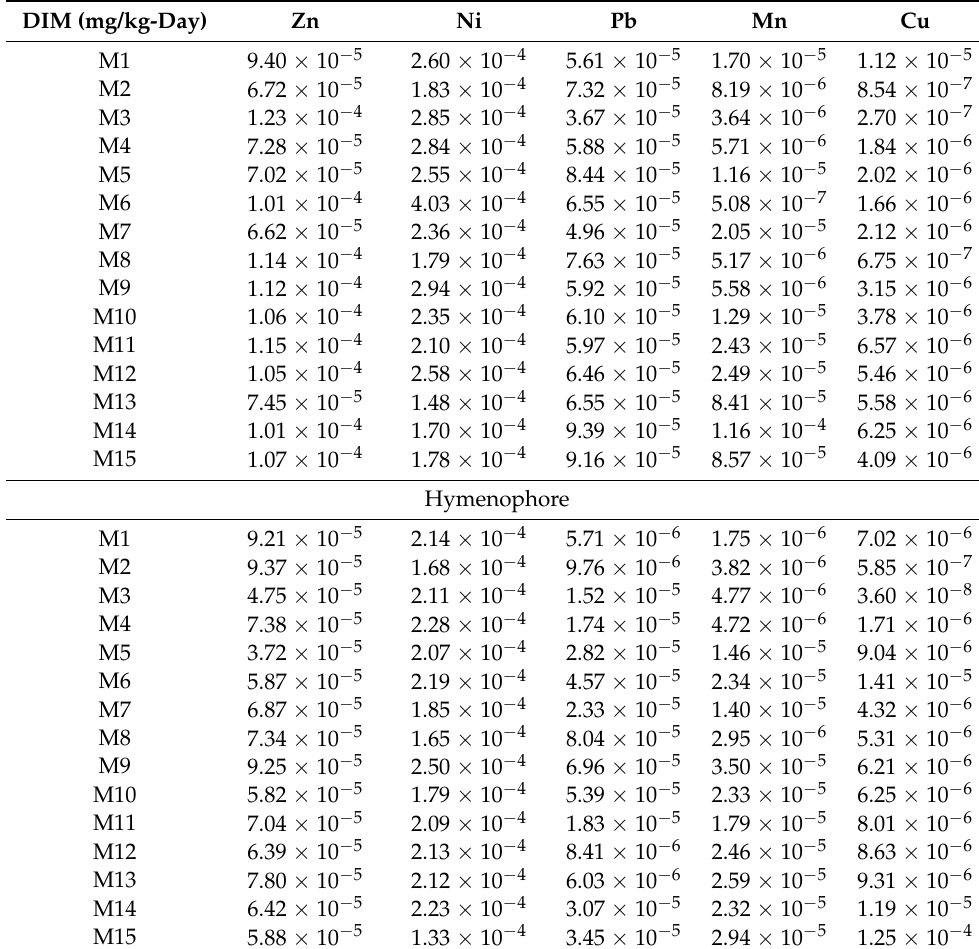
Table 5. The daily dietary intake of metals (DIM) through consumption of potentially contaminated M. galilaea (FB and